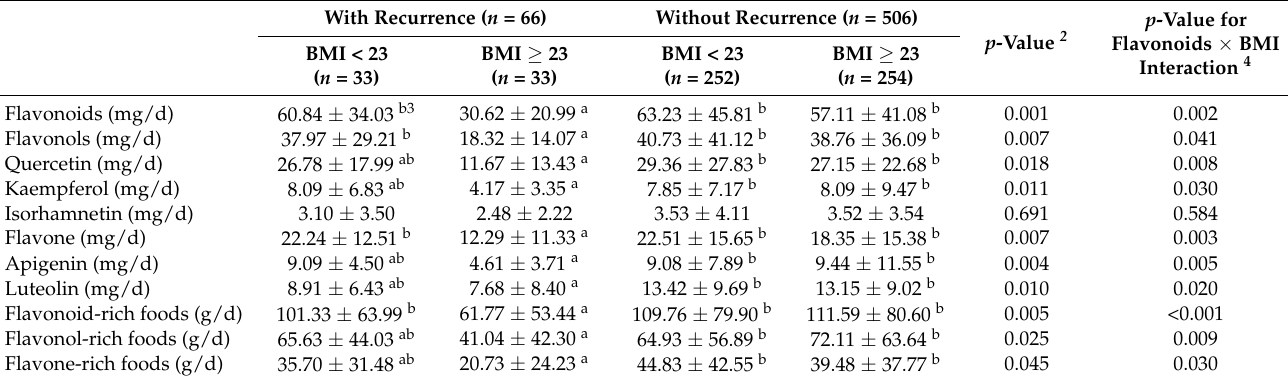
Table 2. Consumption of flavonoids in patients with and without cancer recurrence. 1